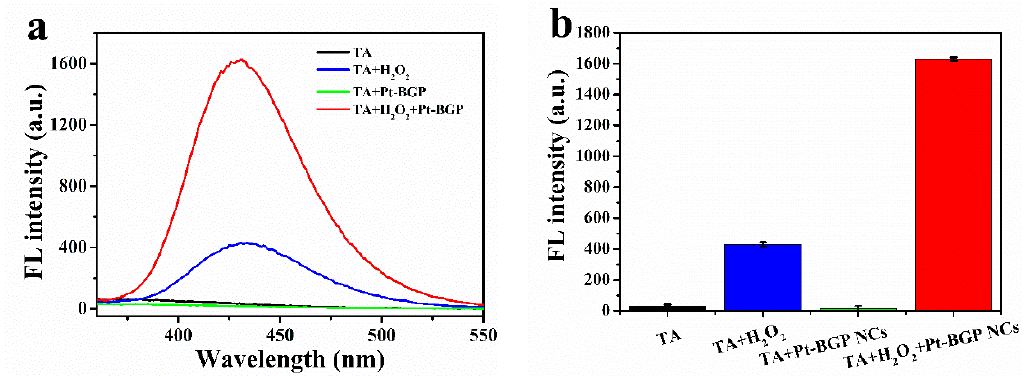
Figure 6. ( a ) Fluorescence spectra of TA, TA + H 2 O 2 , TA + Pt-BGP NCs and TA + H 2 O 2 + Pt-BGP NCs after incubation for 12 h; ( b ) histograms of fluorescence intensity at 435 nm.